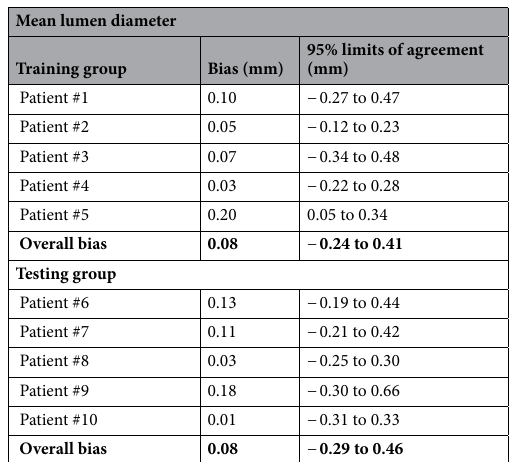
Table 5. Comparison of mean lumen diameter between computational stenting versus optical coherence tomography in clinical cases by Bland–Altman analysis.